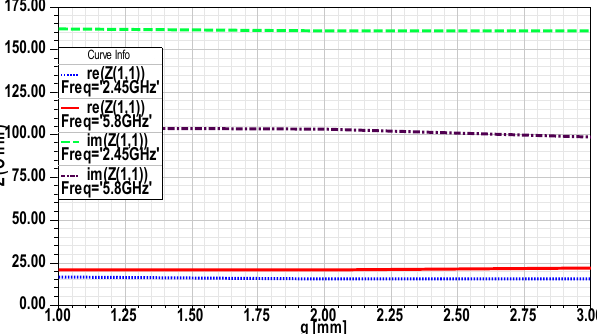
Fig. 11. Effect of space d on input